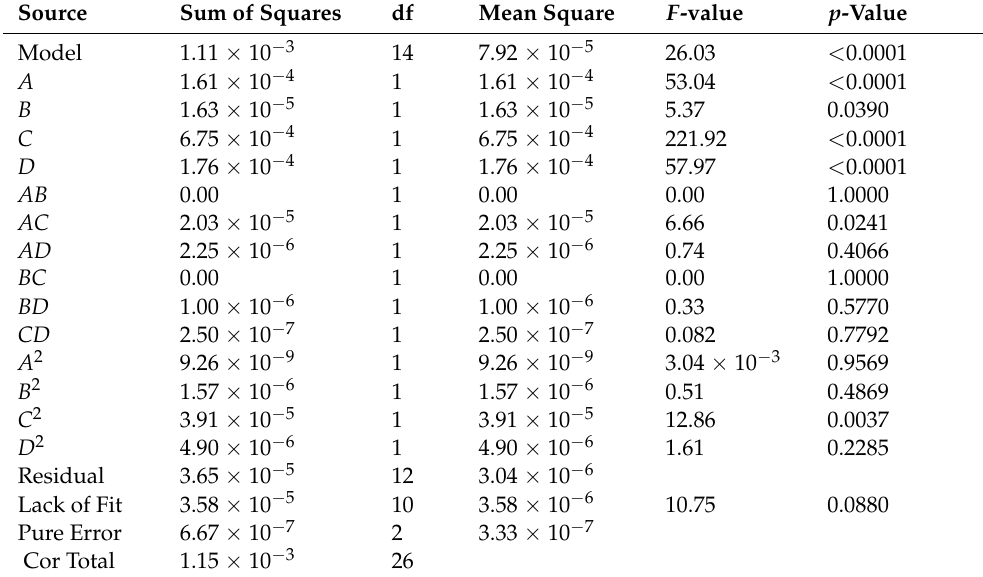
Table 5. Analysis of variance of